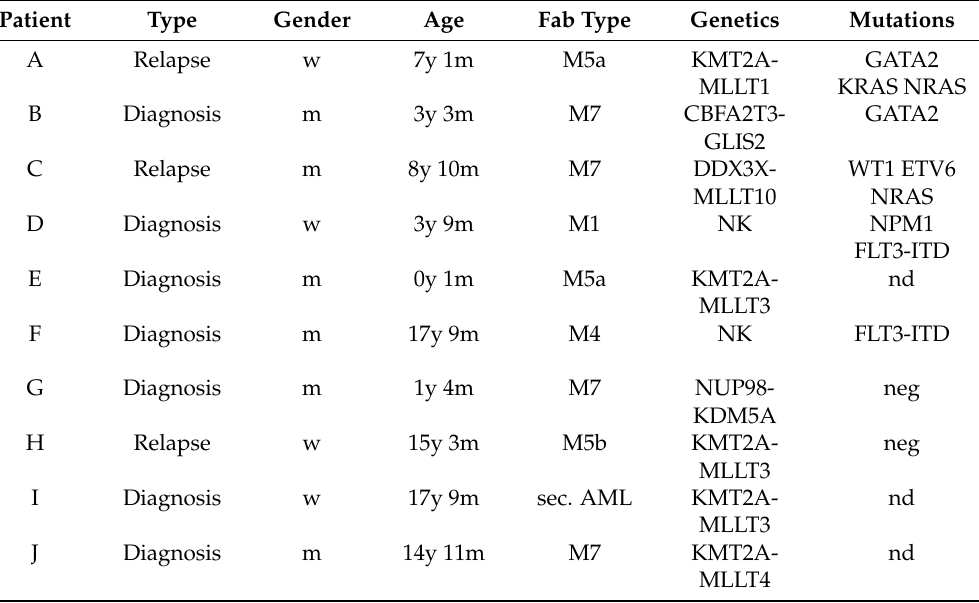
Table A3. Detailed clinical and biological characteristics of patients present in the data set used.